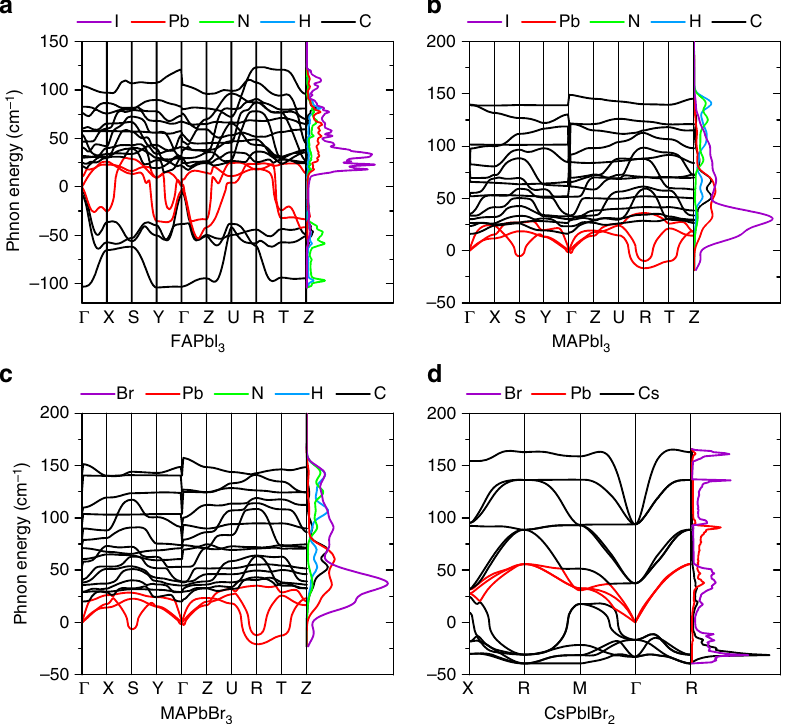
Figure 3 | Phonon band structure and projected phonon DOS. In ( a ) FAPbI 3 ; ( b ) MAPbI 3 ; ( c ) MAPbBr 3 ; ( d ) CsPbBr 3 . The projected phonon DOS are given in arbitrary units (a.u.) and show the contributions of the organic cation and inorganic sub-lattice respectively. The acoustic bands are plotted in